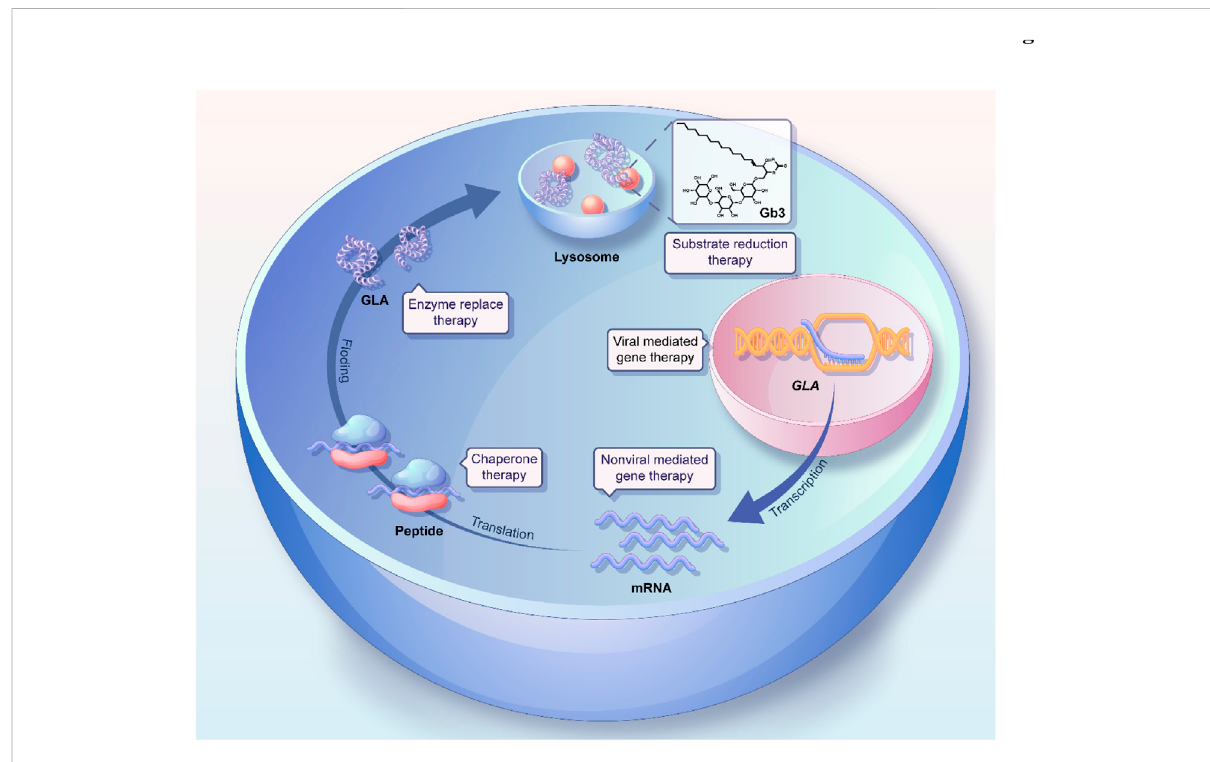
FIGURE 1 Schematic illustration of the GLA synthetic process and the various therapeutic strategies for Fabry